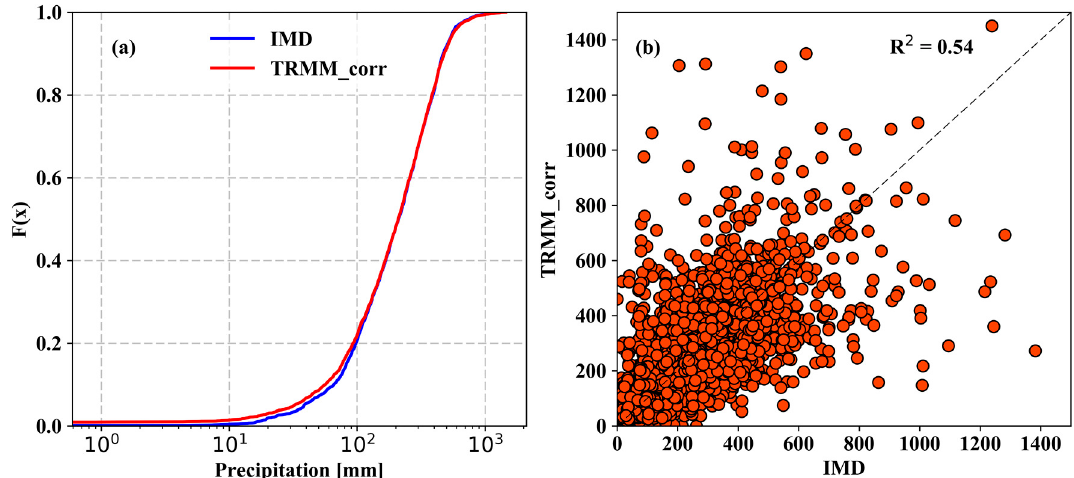
Figure 5. Consistency analysis of bias corrected rainfall estimated from TRMM with station observed rainfall from IMD through ( a ) comparison between empirical CDFs and ( b ) scatter plot of monthly rainfall from the two datasets over the Upper Ganga Basin.